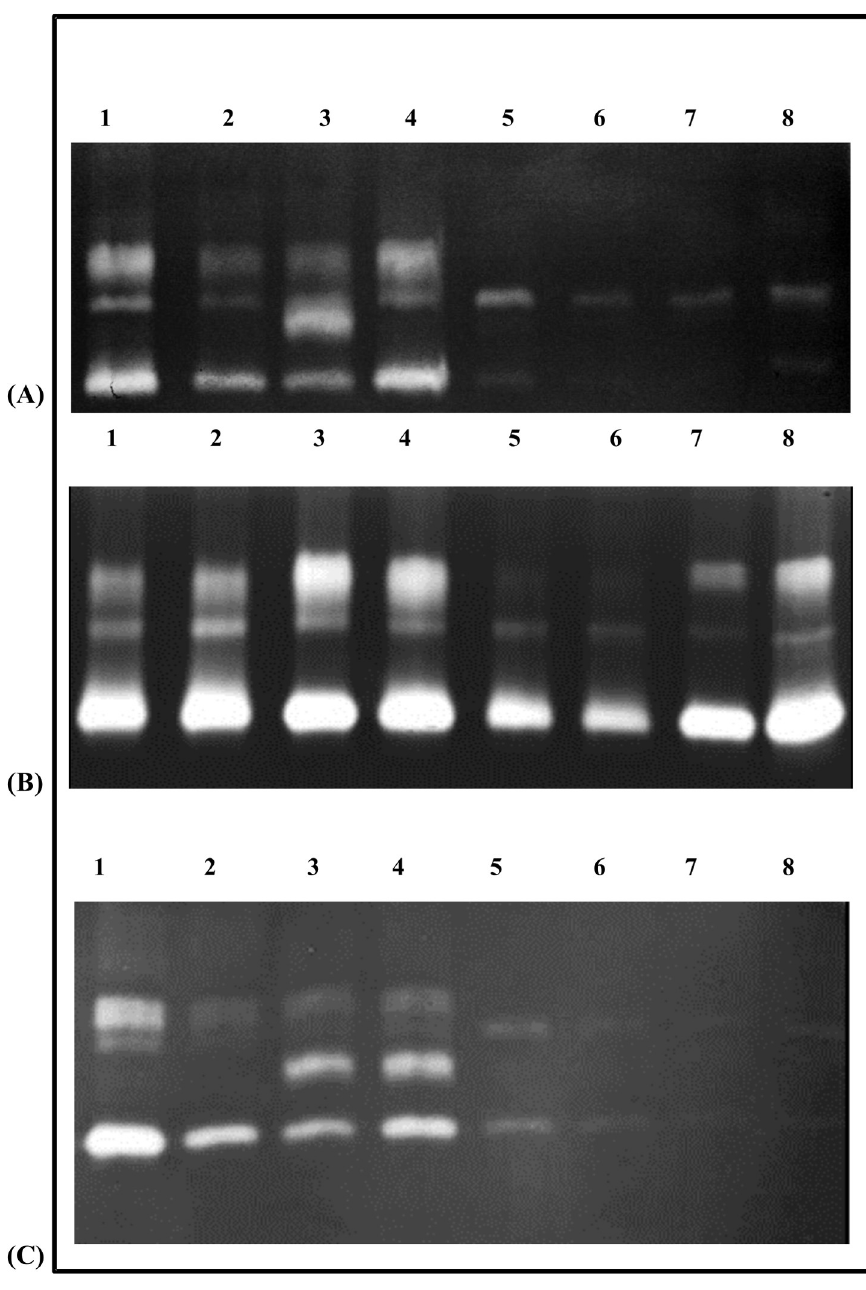
Fig 4. A 12% gelatinolytic zymograms showing different profiles of protease activities in gut extracts of P . brassicae larvae of different ages fed on different diets. Panels show results for (A) III instars, (B) IV instars, and (C) V instars, feeding on (lane 1) CF-CF, (lane 2) CF-GN, (lane 3) GN-GN, and (lane 4) GN-CF diets, while lanes 5–8 correspond to the same samples incubated with 5mM